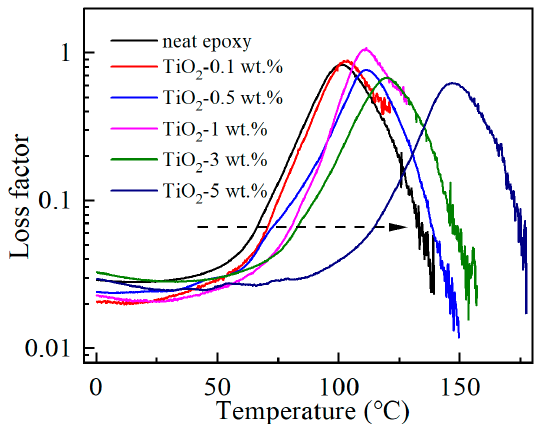
Figure 4. Loss factor of epoxy / TiO 2 samples.